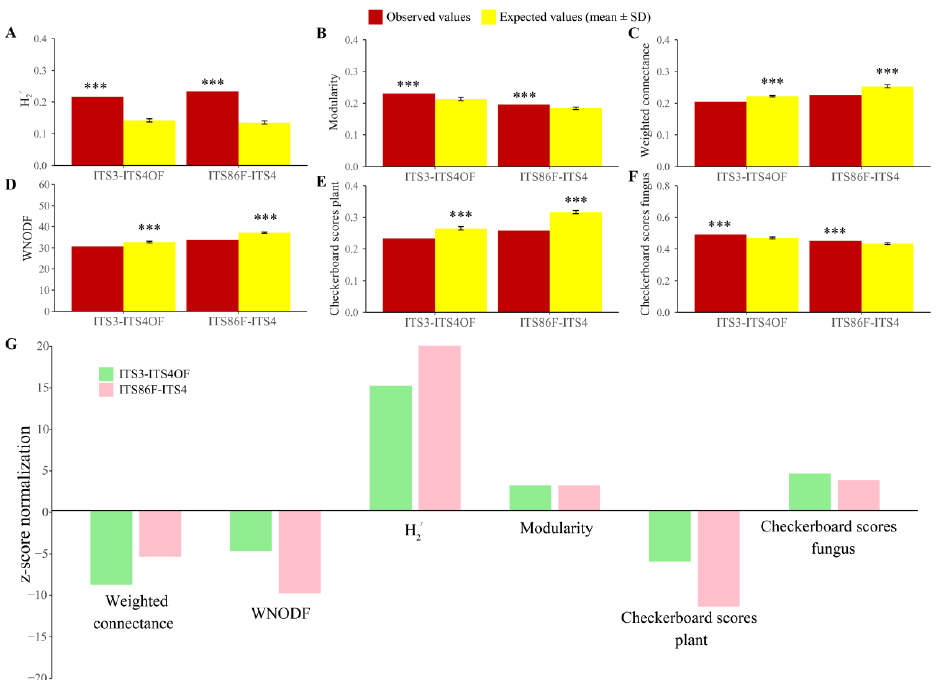
Figure 5. Architecture of the plant–fungus network. ( A ) H 2 (cid:48) metric of the network-level interaction specialization. ( B ) Barber’s metric of modularity. ( C ) Weighted connectance. ( D ) Weighted nestedness metric based on overlap and decreasing fill (WNODF). ( E ) Checkerboard scores representing the extent to which the overlap of fungi is avoided in the plant community. ( F ) Checkerboard scores representing the extent to which the overlap of plants is avoided in the fungal community. ( G ) Standardized network properties with Z-score normalization of endophytic networks from primer pairs ITS3/ITS4OF and ITS86F/ITS4. Asterisks indicate significant differences between the observed and expected values according to t test (*** p <